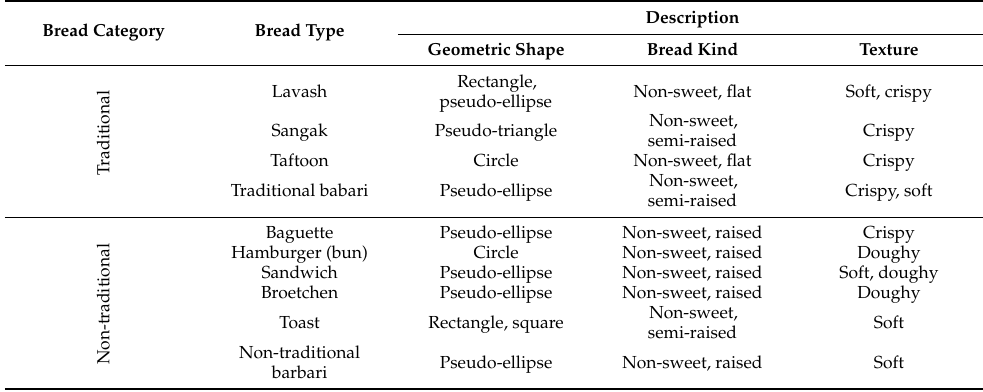
Table 1. The description of the studied bread types based on their categories and characteristics. Description Bread Category Bread Type Geometric Shape Bread Kind Texture Lavash Rectangle, pseudo-ellipse Non-sweet, flat Soft, crispy Sangak Pseudo-triangle Non-sweet, semi-raised Crispy Taftoon Circle Non-sweet, flat Crispy Traditional babari Pseudo-ellipse Baguette Pseudo-ellipse Circle Doughy Toast Rectangle, square Non-sweet, semi-raised Soft Non-traditional barbari